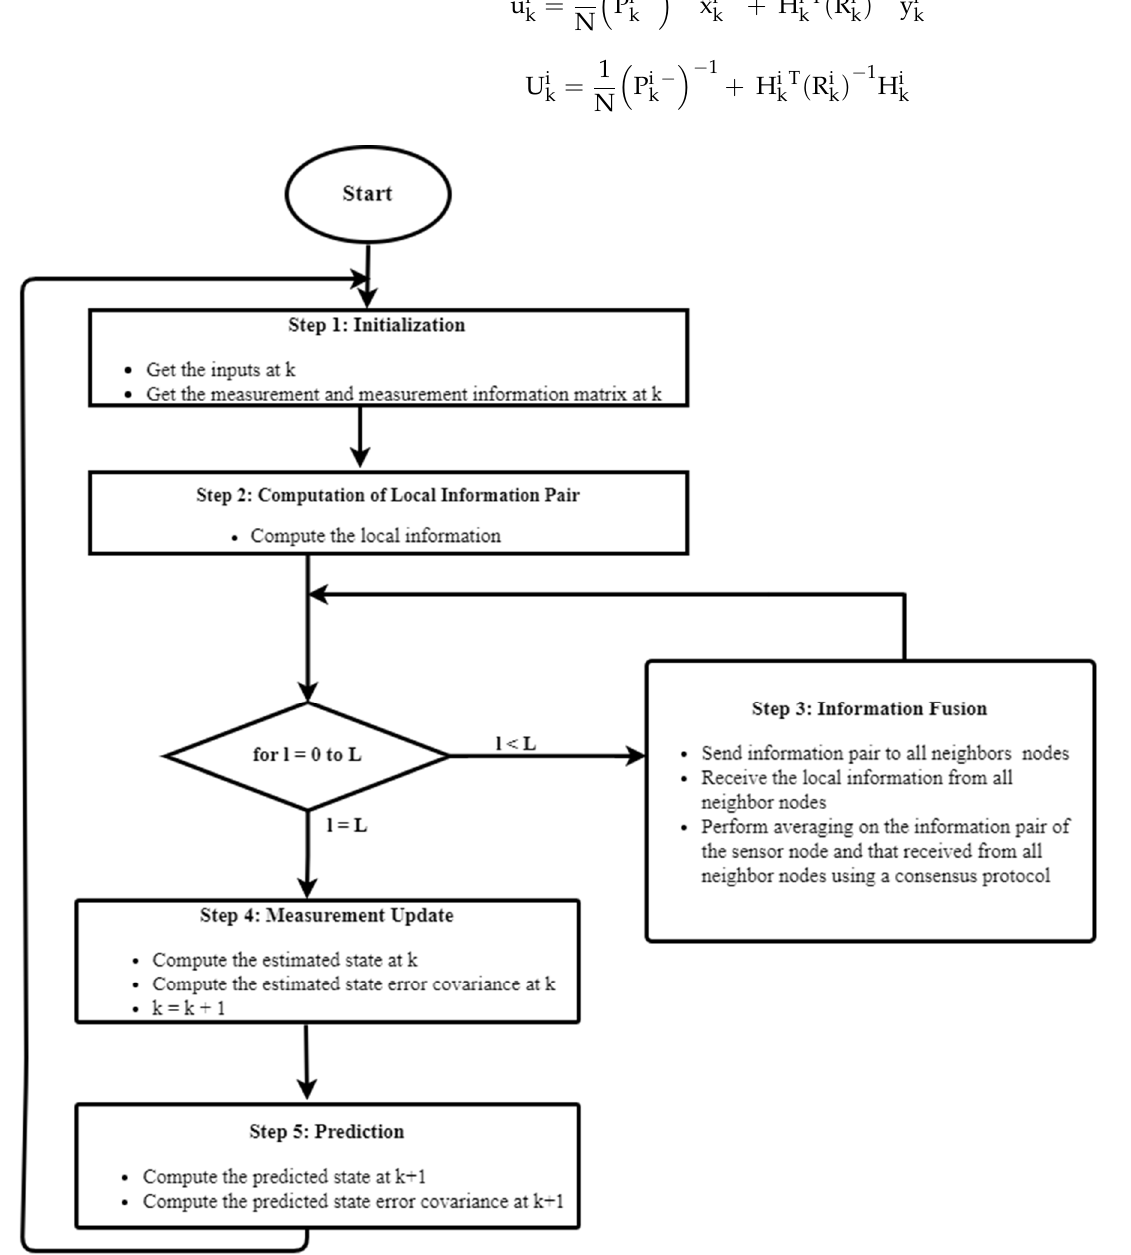
Figure 2. Flowchart of ICF algorithm.